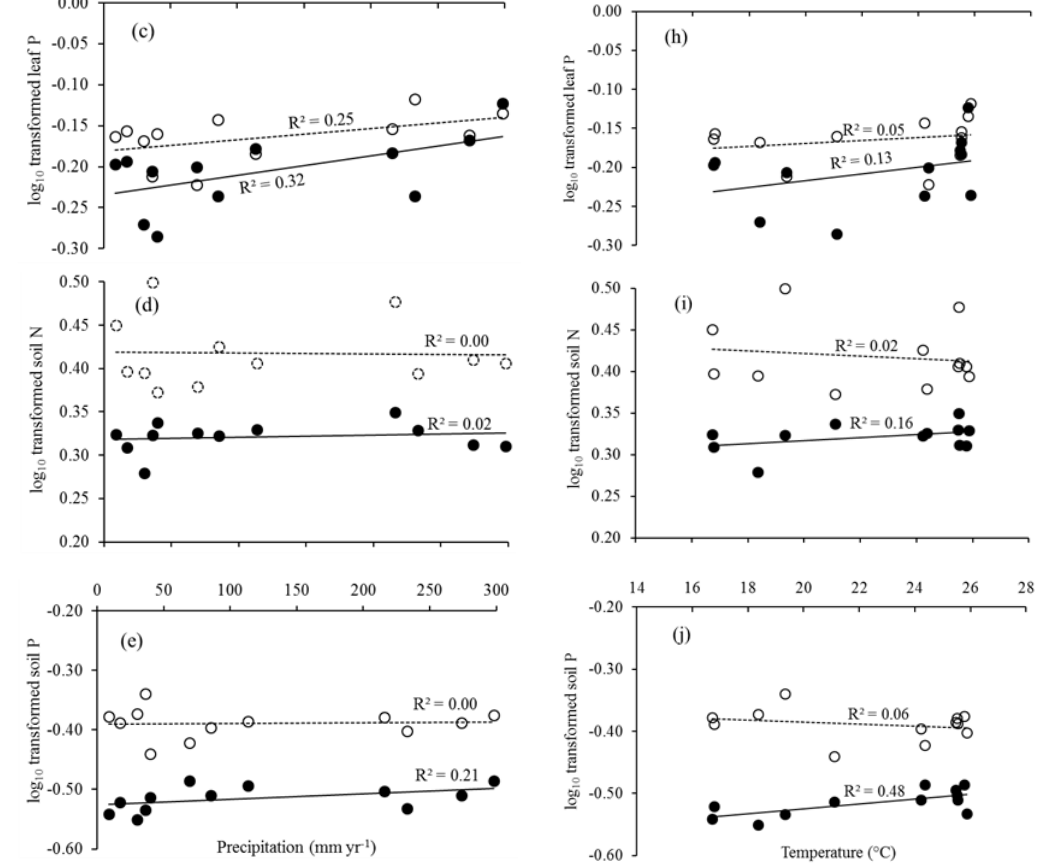
Figure 3. Leaf litter N and P, and soil N and P in relation to precipitation and temperature. pH, leaf litter N, leaf litter P, soil N, and soil P in relation to precipitation ( a , b , c , d , and e , respectively) and temperature ( f , g , h , i , and j , respectively). Solid trend lines represent the site PTF and dotted lines the site STF.